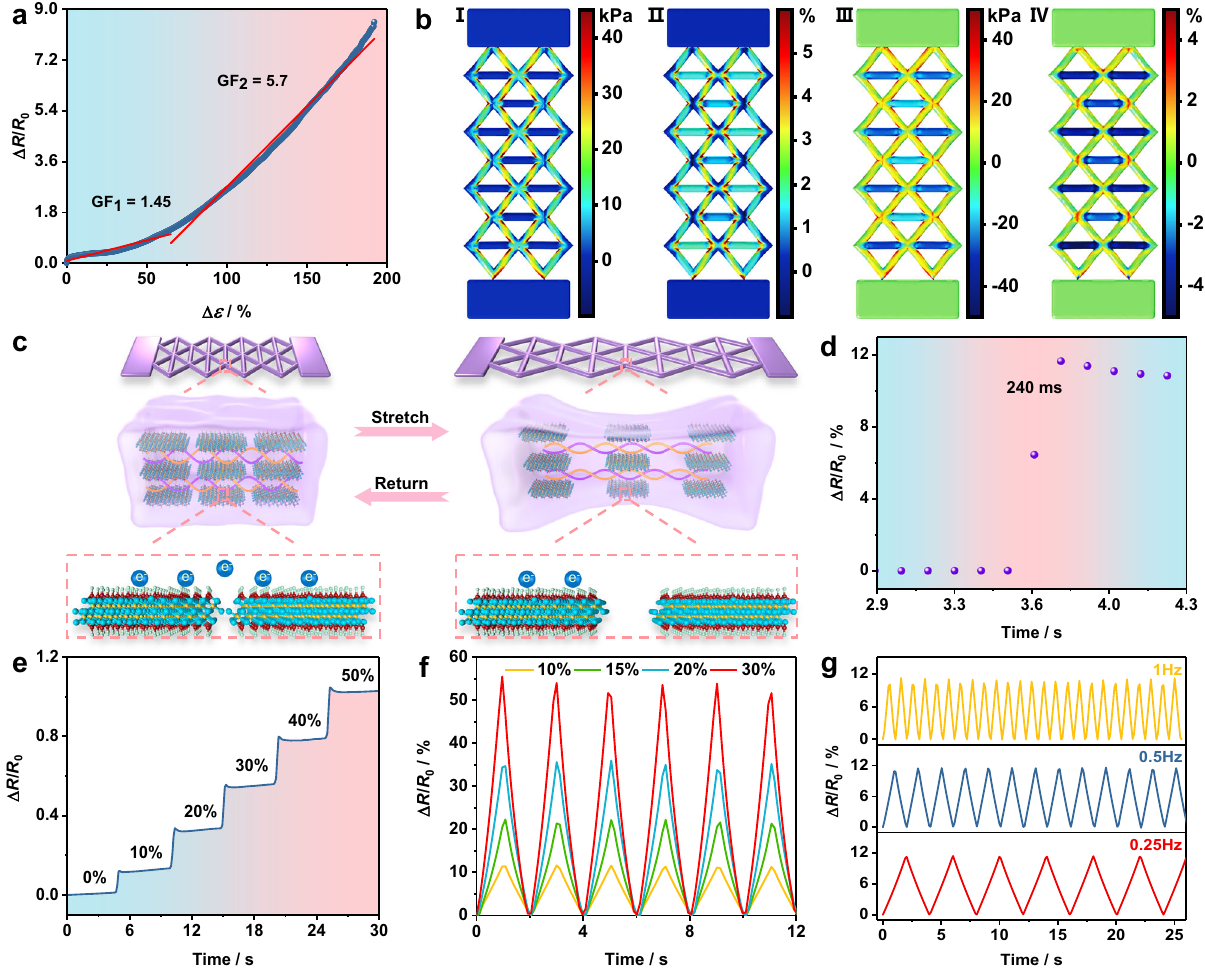
Fig. 3 Strain sensing performance of printed hydrogel. a Gauge factor (GF) and ( b ) stress – strain distribution simulation of stretched sensor. I Stress and II strain distribution along stretching direction, III stress and IV strain distribution in horizontal direction. c Schematic illustration of sensing mechanism. d Response time of the printed sensor. Relative resistance change ( Δ R / R 0 ) under ( e ) step strains, ( f ) six cyclic stretching-releasing with frequency of 0.5 Hz, and ( g ) different frequencies with 10%